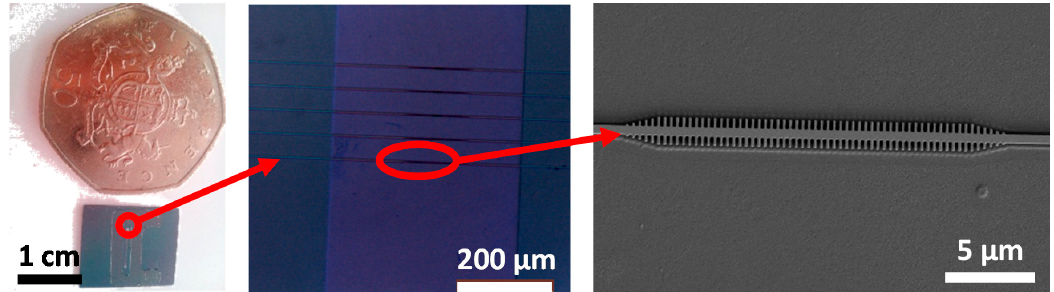
Figure 3. ( Left ) Image of the photonic chip fabricated in SOI technology. The circle depicts the position of one of the photonic bandgap (PBG) sensor groups. ( Center ) Microscope image of a PBG sensor group. The fifth structure on the top of the group corresponds to a reference waveguide. The channel opened on the SiO 2 upper cladding can also be observed. The circle depicts an individual PBG sensing structure. ( Right ) Scanning electron microscope (SEM) image of a fabricated PBG sensing structure.